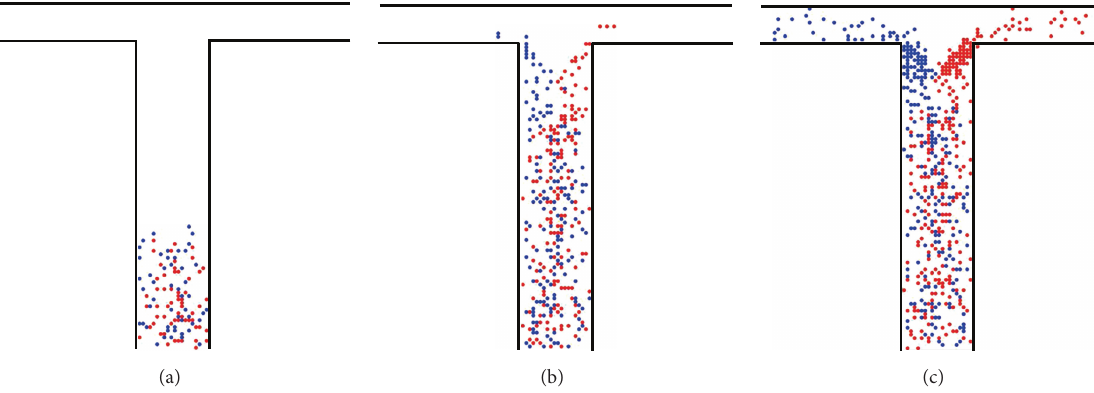
Figure 8: The simulation of separating pedestrian flow with guide sign. (a) LP and RP are generated at the down origin of main passage; (b) LP and RP see the guide sign and generate the subconscious behavior; (c) LP and RP arrive at the exit and walk away.